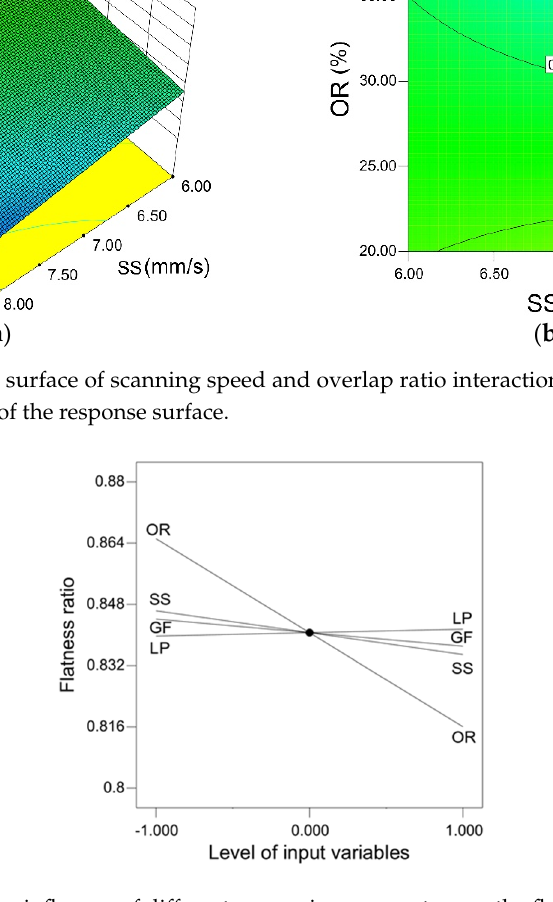
Figure 6. ( a ) Response surface of scanning speed and overlap ratio interaction affecting the flatness ratio; ( b ) Contour line of the response surface.